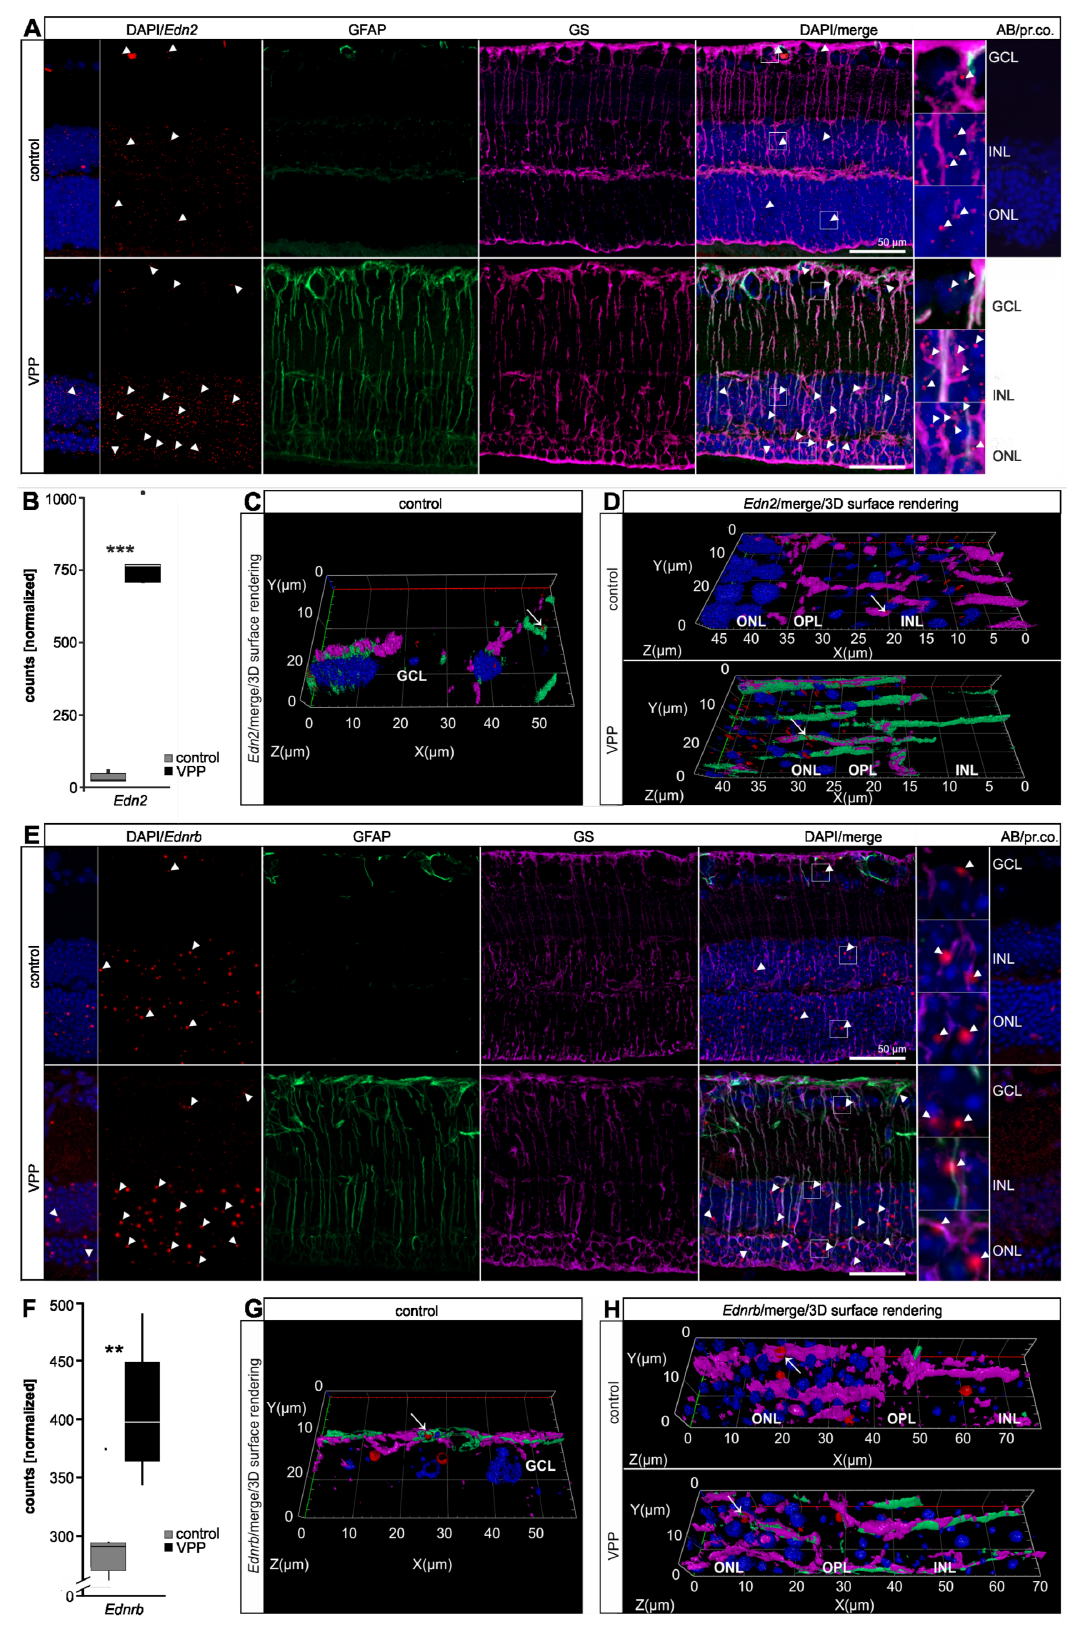
Figure 3. Upregulation of endothelin signaling in VPP mice. ( A ) In situ hybridization for Edn2 (red, arrowheads) and GFAP (green)/GS (purple) immunofluorescence co-labeling in the retinae of three-month-old animals. Nuclei were DAPI-stained